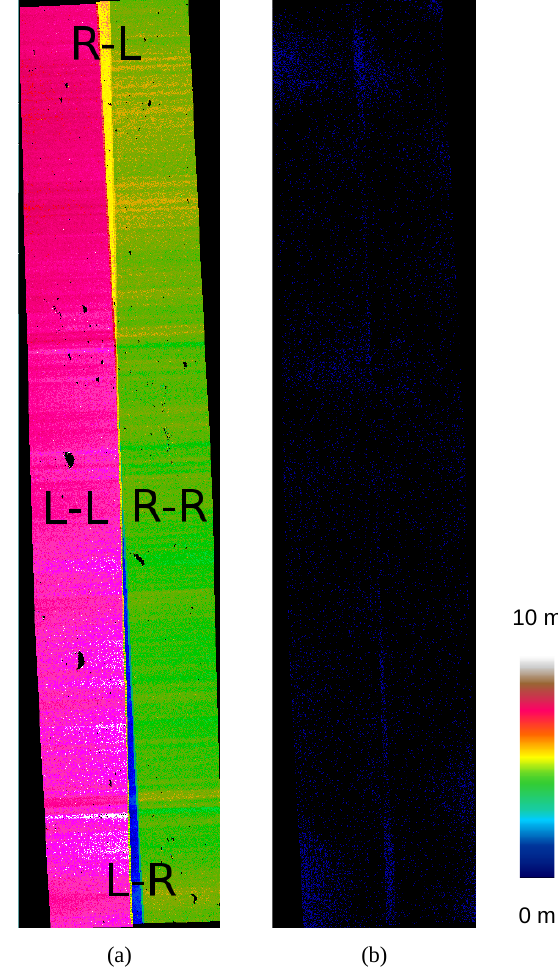
Figure 2: Color-coded representation of the intersection errors. (a) Initial errors of the camera positions and pointings result in high intersection errors of up to ~10 m. (b) After bundle adjustment the